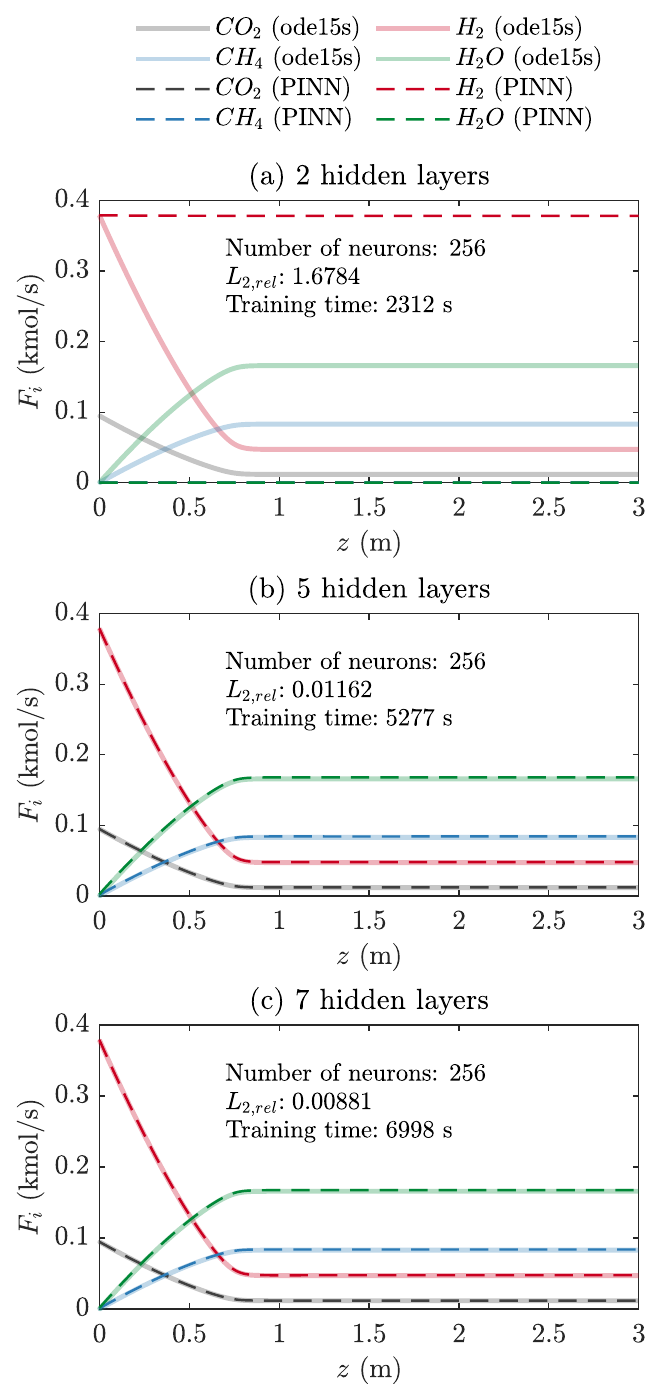
Figure 6. Performance of PINN models with different numbers of hidden layers: ( a ) 2 hidden layers, ( b ) 5 hidden layers, and ( c ) 7 hidden layers.